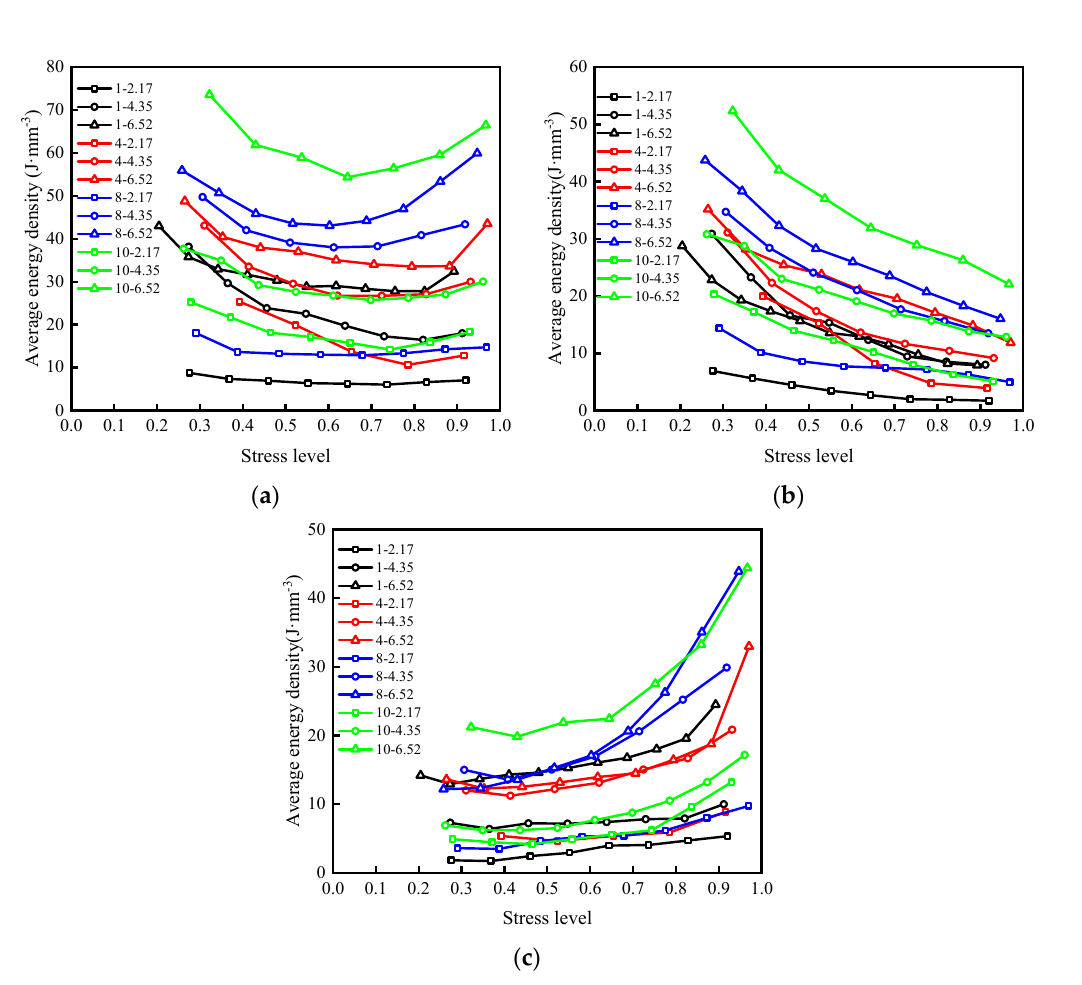
Figure 7. Relationship between energy density and stress level of samples under different working conditions: ( a ) u ; ( b ) u e ; ( c ) u d .